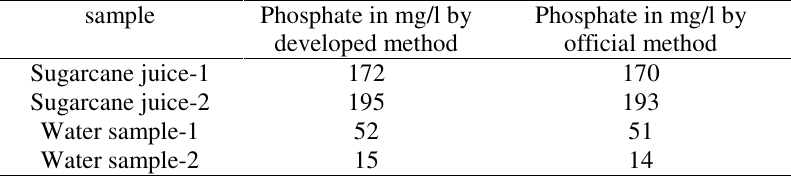
Table 2. Determination of phosphate in detergent powders Phosphate in % Company